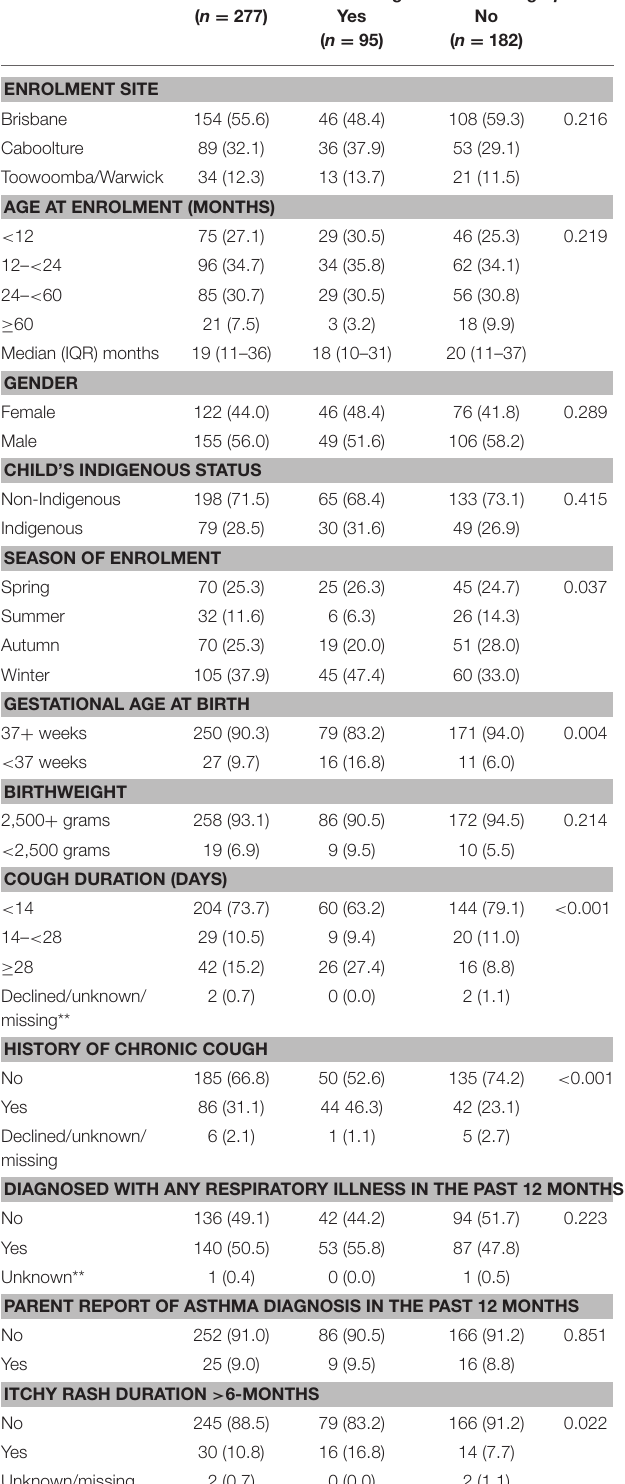
TABLE 1 | Selected baseline characteristics comparing children with and without CC, n = 277 (%).